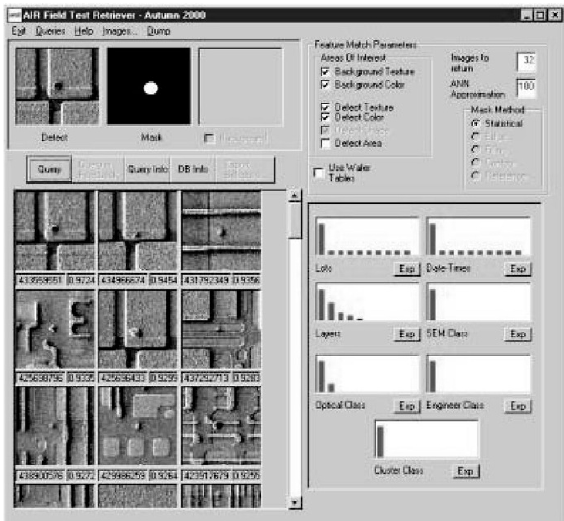
Figure 1: Example interface to the AIR system. Queries are entered in the upper left, results are displayed below in the lower left, and as- sociated statistical process information is shown in the lower right. AIR control parameters are listed in the upper right.